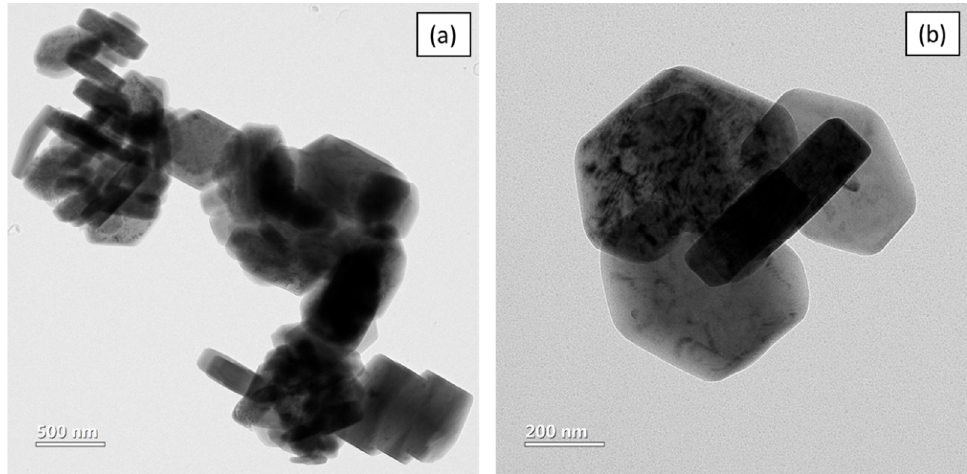
Figure 2. ( a , b ) TEM of Mg(OH) 2 .